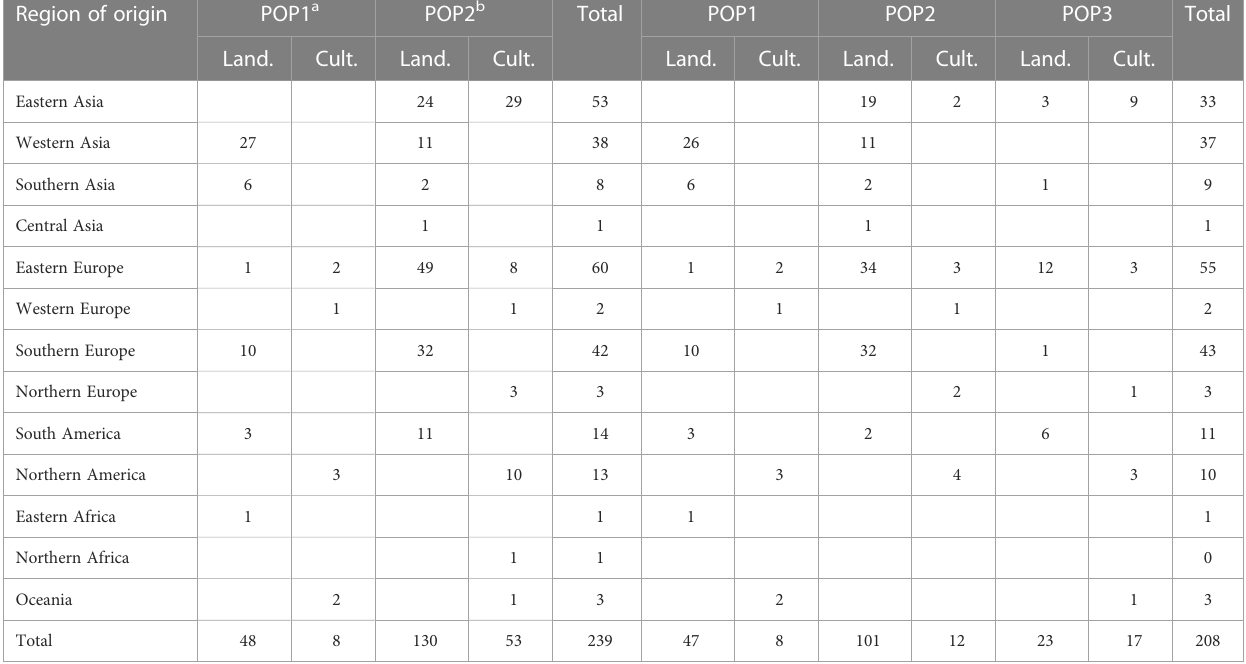
TABLE 2 Grouping of 288 oat accessions based on STRUCTURE analysis at K = 2 and K = 3. Region of origin POP1 a POP2 b Total Land. Cult. Land. Cult. Land. Cult. Land. Cult.